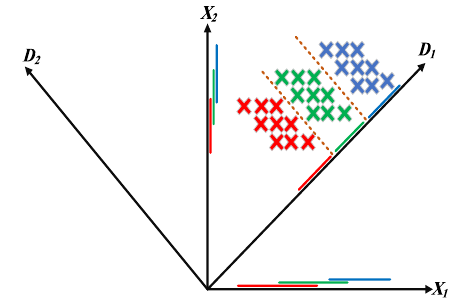
Fig. 3 Introduction of principal component analysis